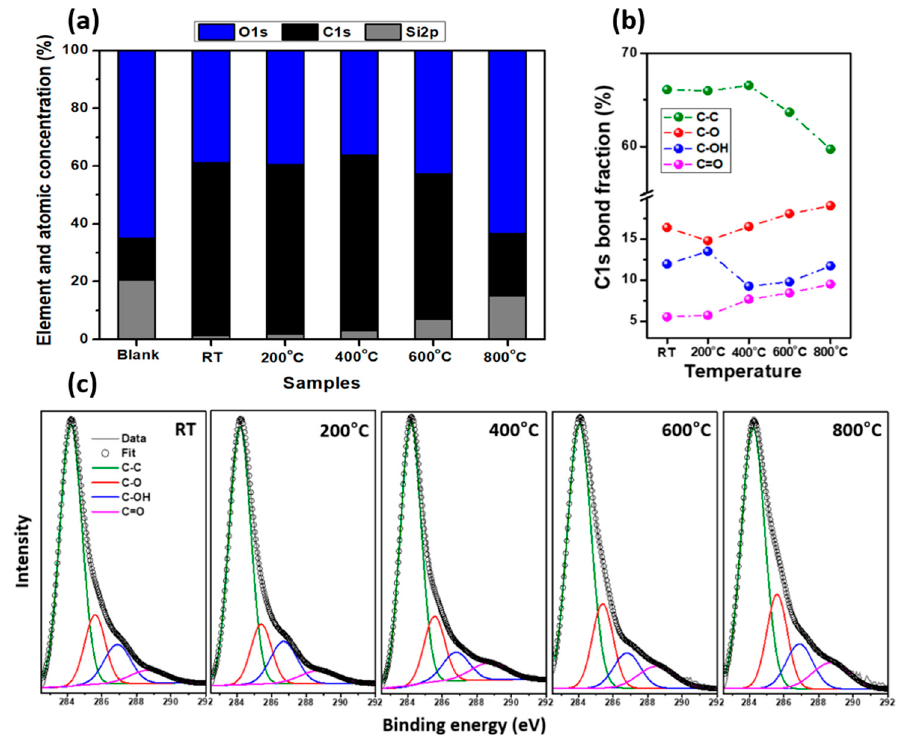
Figure 4. (a) Element and atomic concentration survey; (b) the C1s bond fraction indicates the var- variation in C–C, C–O, C–OH, and C=O content with increasing treatment; and ( c ) XPS spectra of iation in C–C, C–O, C–OH, and C=O content with increasing treatment; and (c) XPS spectra of synthesized aBC samples treated at five different synthesized aBC samples treated at five different temperatures.